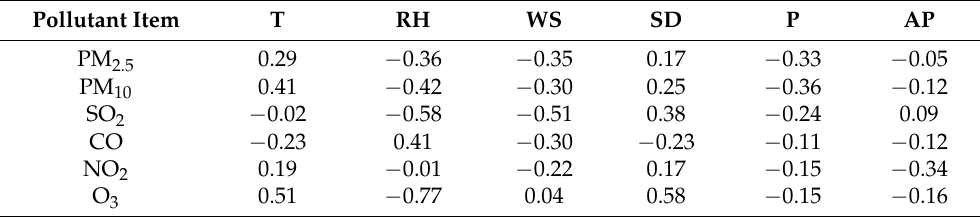
Table 1. Pearson correlation coefficients between daily mean concentrations of air pollutants and me- teorological parameters from 3 January 2020 to 8 March 2020 in Guiyang city (T: temperature, SD: sun- shine duration, WS: wind speed, RH: relative humidity, P: precipitation, AP: atmospheric pressure). Pollutant